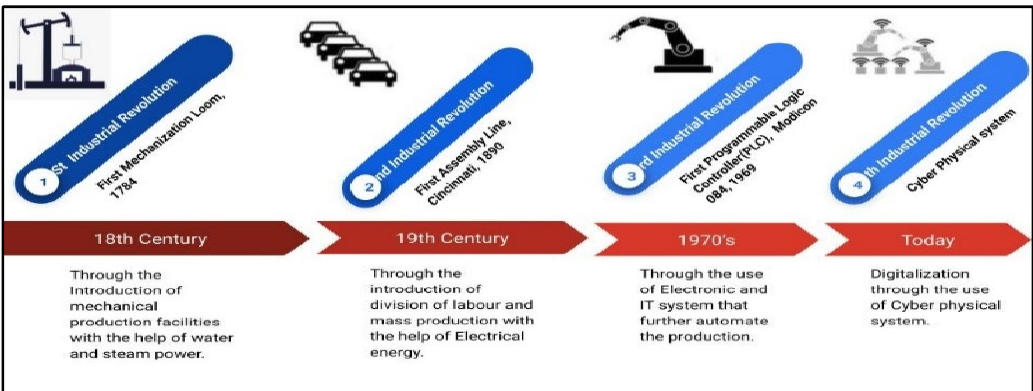
Figure 1. Industry 1.0 to 4.0.